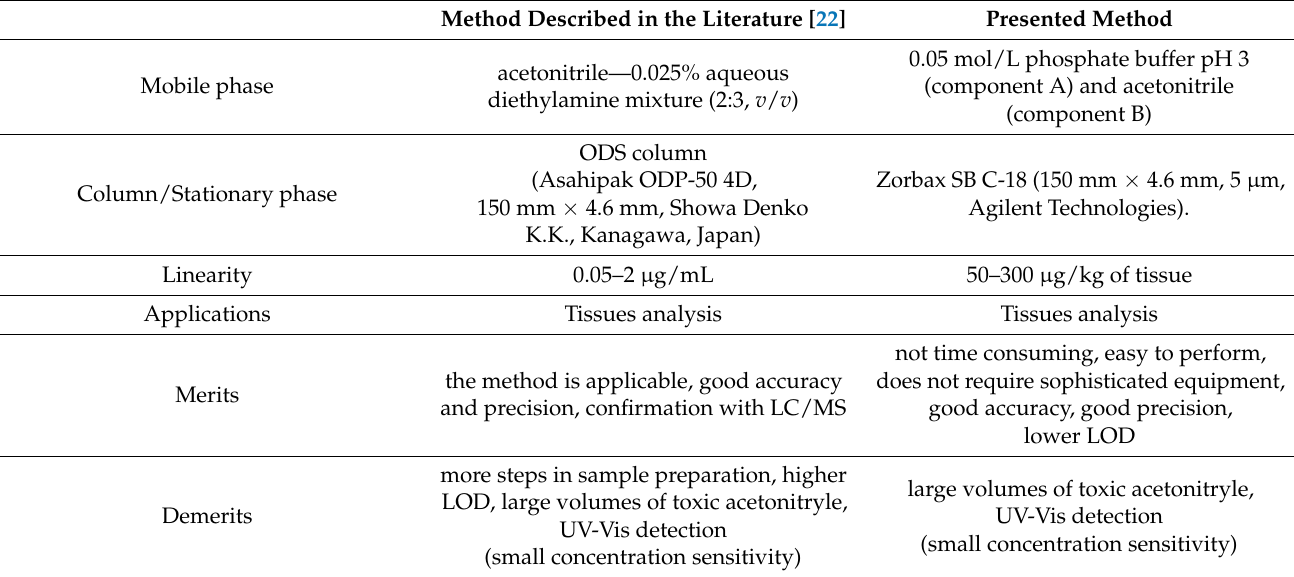
Table 4. Comparison of the presented method with a similar method described in the